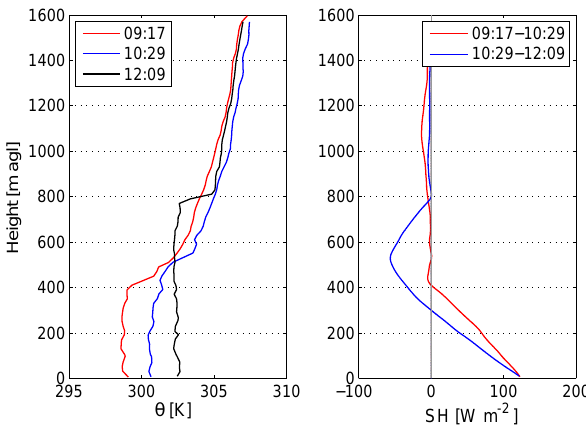
Figure 8. Three subsequent profiles of potential temperature θ taken on 5 July (left panel) and the corresponding calculated profiles of sensible heat flux (right